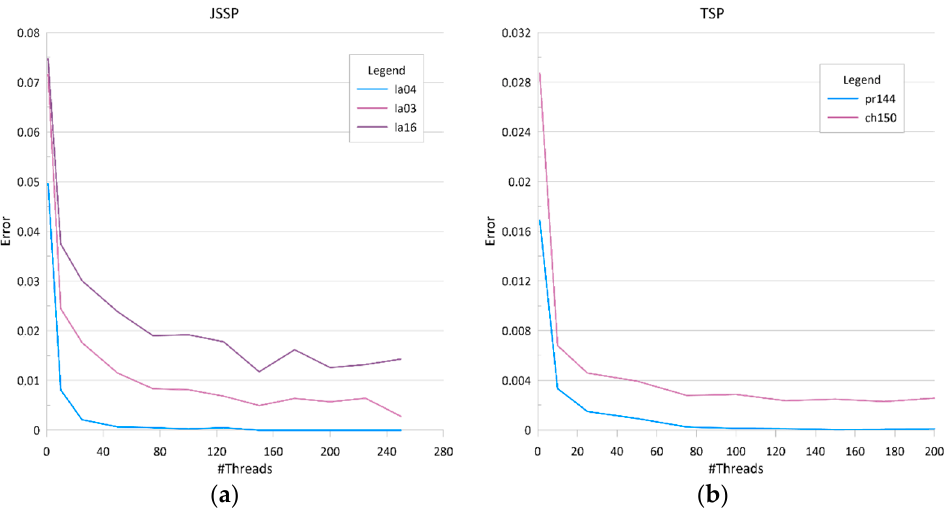
Figure 1. Mean error versus the number of threads for some example ( a ) traveling salesman (TSP) and ( b ) job-shop scheduling (JSSP) datasets.